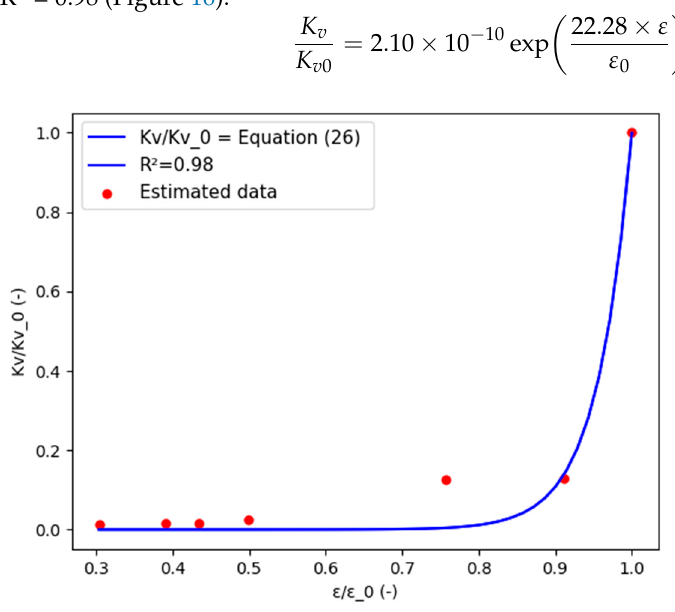
Figure 16. Variation of water vapor normalized permeability with the average compressed MCC PH101 powder tablet normalized porosity.